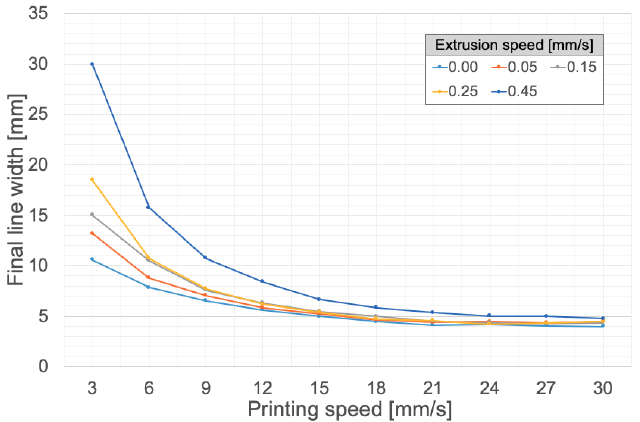
Figure 4. Influence of extrusion speed and printing speed on the final line width. Silicone: Ecoflex 00-20. Needle diameter: 1.6 mm. Bed temperature: 90 °C.